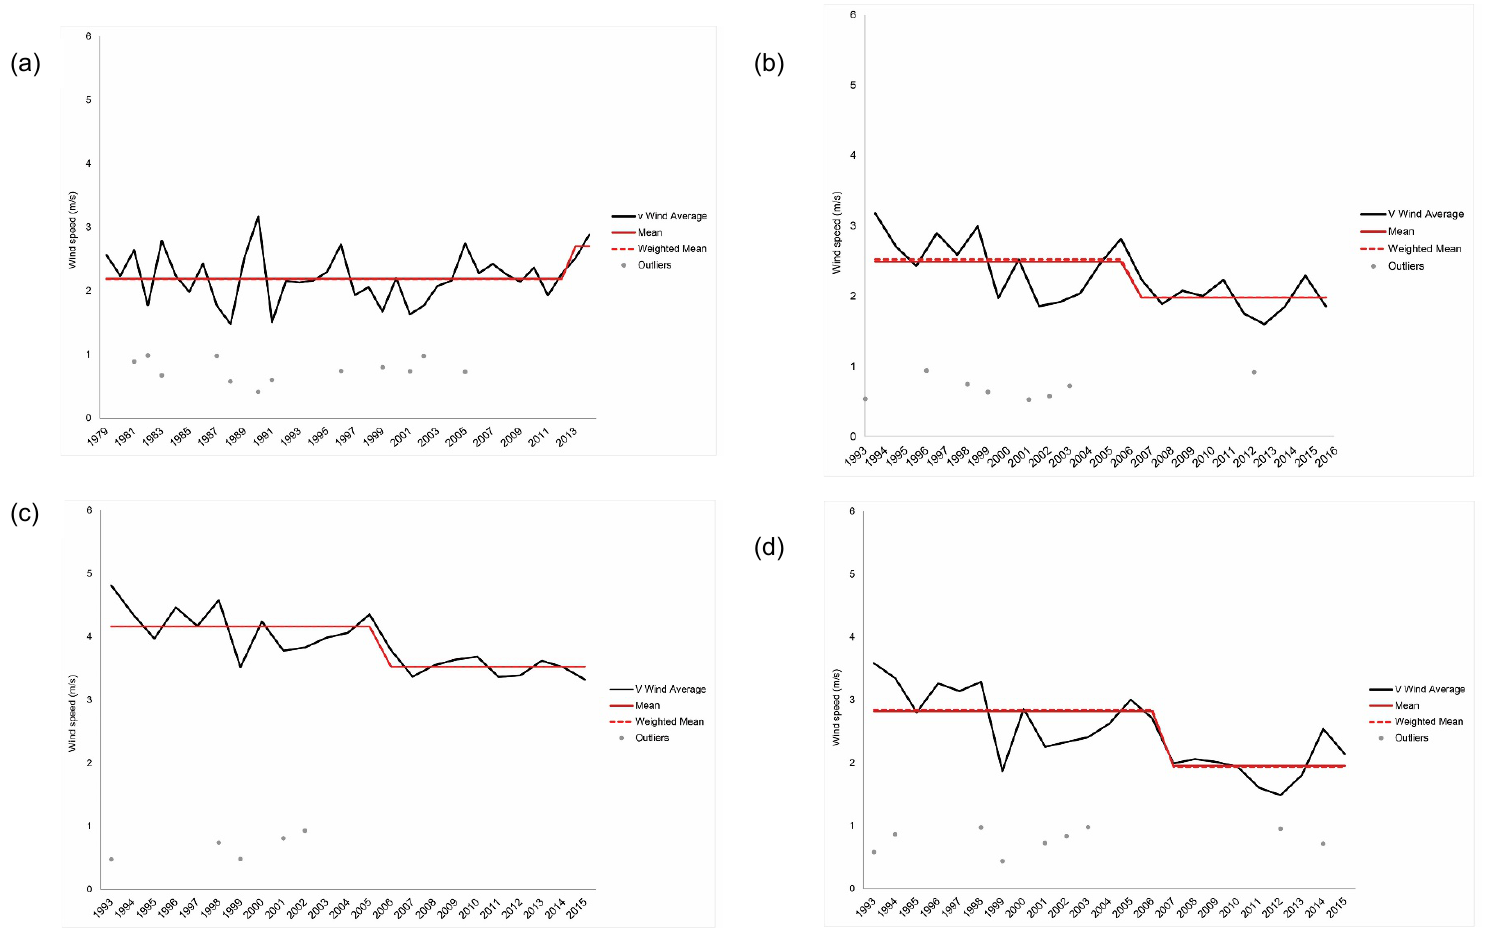
Figure A5.2: Summer mean values for V component of wind speed for (a) NCEP-DOE, (b) scatterometer aggregate, (c) Witsand and (d) Mossel